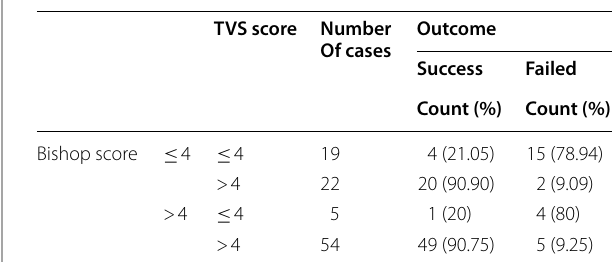
Table 6 Relation between bishop score and TVS score with outcome of induction of